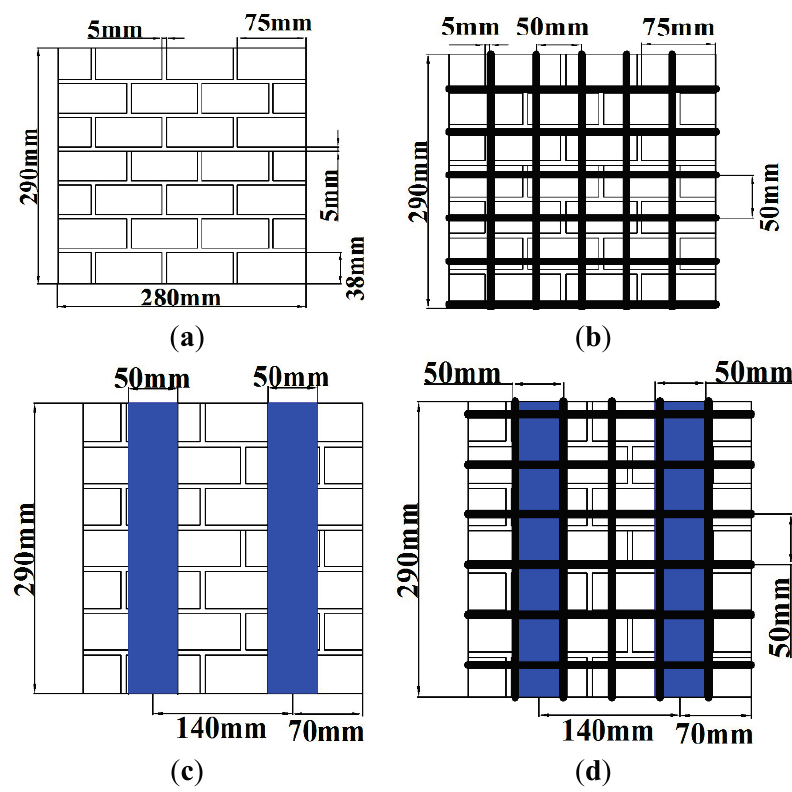
Figure 12. Panel retrofitting scheme for in-plane diagonal compression test: ( a ) non-retrofitted masonry panel, ( b ) PP-band retrofitted masonry panels, ( c ) FRP retrofitted masonry panel, and ( d ) FRP + PP-band retrofitted masonry